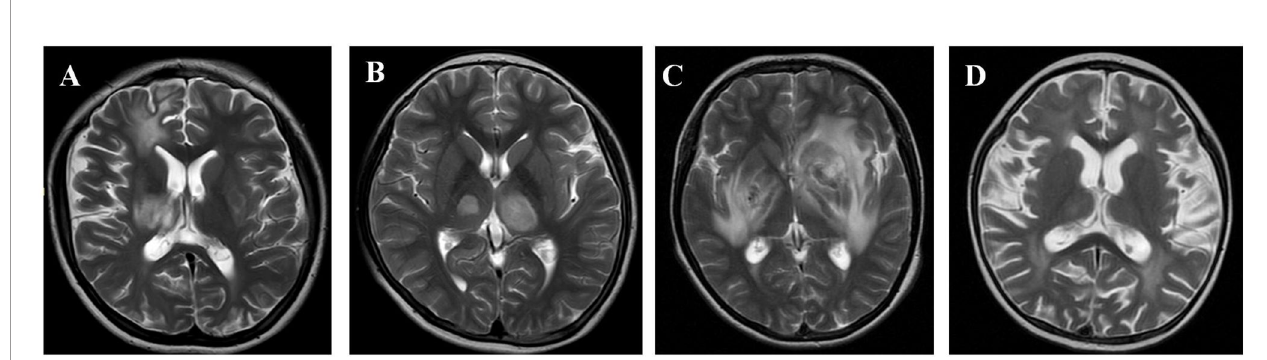
FIGURE 1 | Cranial magnetic resonance imaging of patients. (A) Patient P1: Multiple abnormal bilateral signals in the brain. Both old and new lesions coexist. Demyelinating lesions may be present. (B) Patient P2: Sparse abnormal bilateral signals in the brain parenchyma, suggestive of in fl ammatory lesions. (C) Patient P3: Abnormal signals in the brain and cerebellum, particularly in the bilateral basal ganglia and the left frontal lobe, suggestive of infective lesions. (D) Patient P15: Abnormal, bilateral symmetrical signals in the white matter, brain atrophy, and similar signals in the